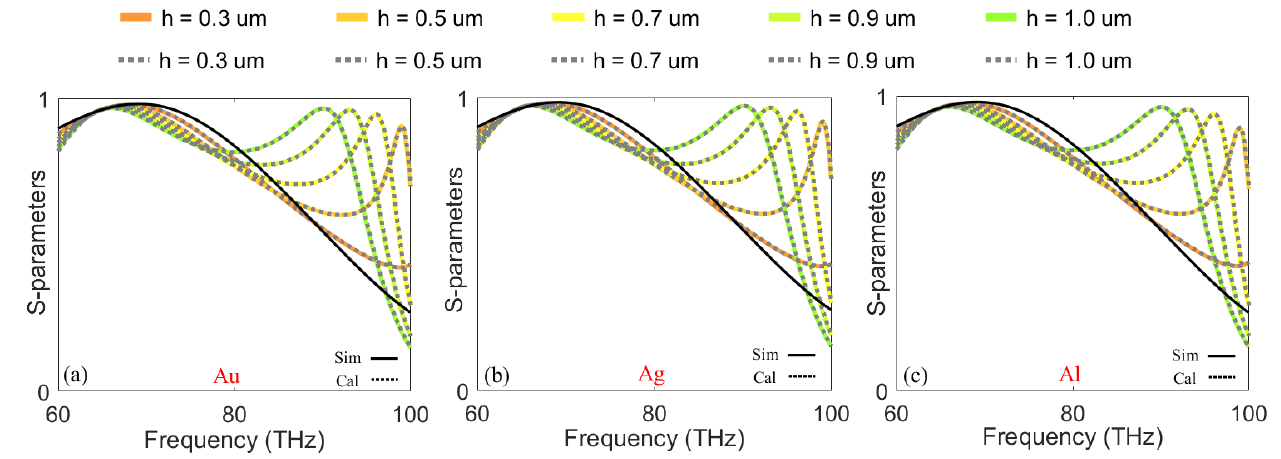
Figure 3. Cascade response when only metallic film is contained on 60 – 100 THz band, wherein the black curve is the case with a thickness of 0.1 um, that is, the cascade benchmark. ( a ) Au; ( b ) Ag; ( c ) Al.